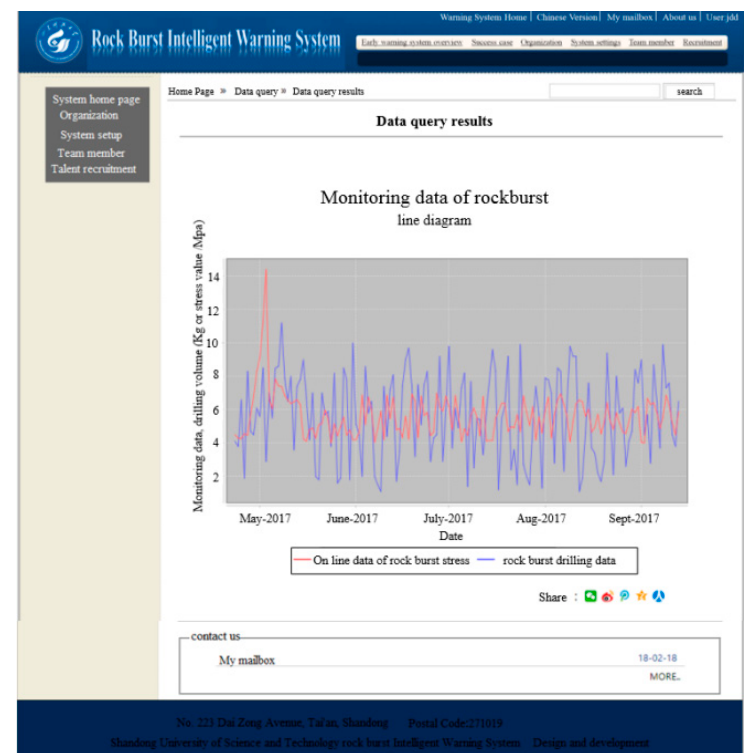
Figure 11. Data query result display page (fold line).